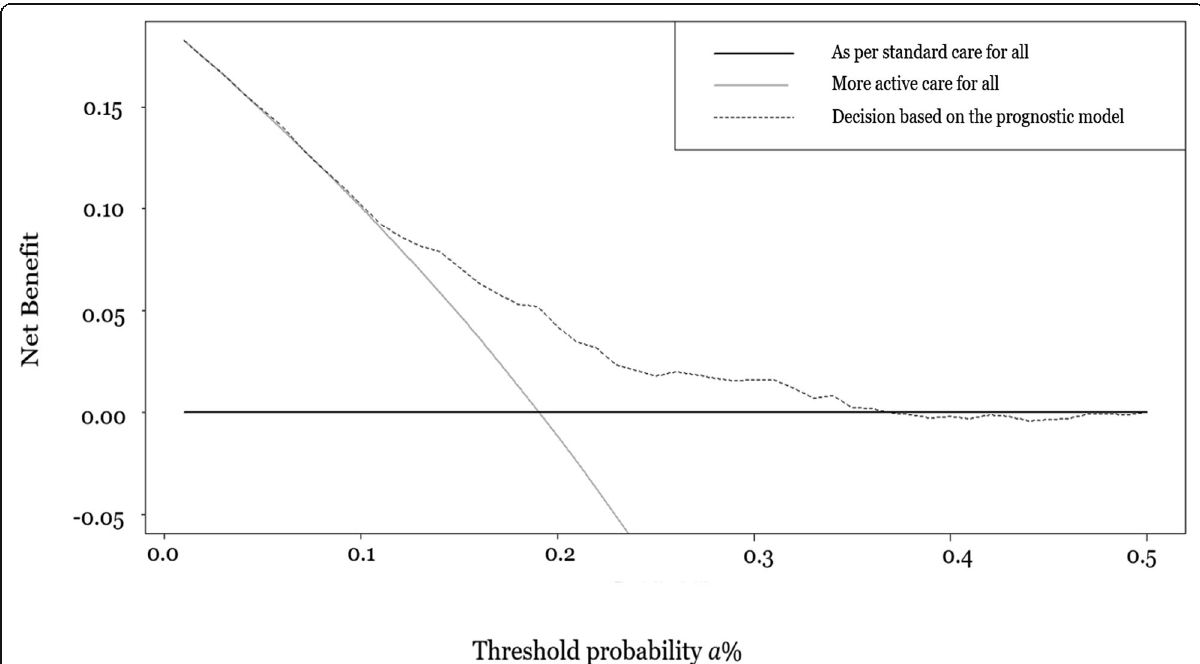
Fig. 4 Decision curve analysis showing the net benefit of the prognostic model per cycle. The horizontal axis is the threshold estimated probability of relapsing within 2 years, a %, and the vertical axis is the net benefit. The plot compares the clinical benefit of three approaches: “ as per standard care for all ” approach, “ more active care for all ” approach, and “ decision based on the prognostic model ” approach (see definitions in “ Clinical benefit of the developed model ” ). For a given threshold probability, the approach with the highest net benefit is considered the most clinically useful model. The “ decision based on the prognostic model ” approach provides the highest net benefit for threshold probabilities ranging from 15 to